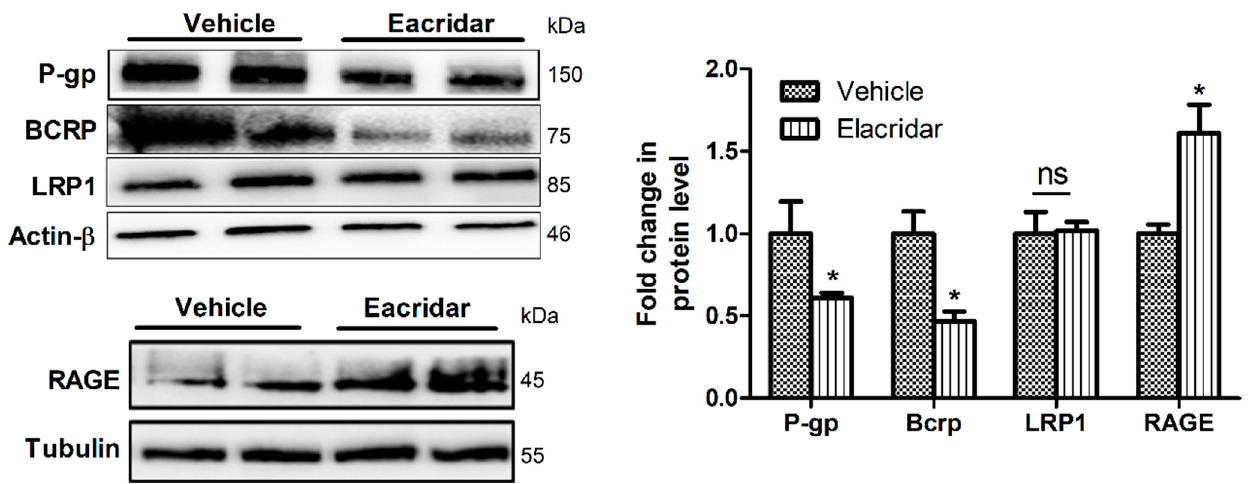
Figure 4. Treatment with elacridar (10 mg/kg) i.p. for 28 days altered the expression A β transport proteins in isolated microvessels from TgSwDI mouse brains. Representative Western blot and densitometry analysis of P-gp, BCRP, LRP1, and RAGE, presented as fold change by elacridar on each protein compared to vehicle treatment, demonstrated that elacridar reduced the expression of P-gp and BCRP, while increased RAGE. Statistical analysis was determined by Student’s t -test. Data represented as mean ± SEM of n = 5 mice per group, ns = not significant; * p < 0.05 compared to vehicle-treated mice. kDa indicates the molecular weight of analyzed proteins.